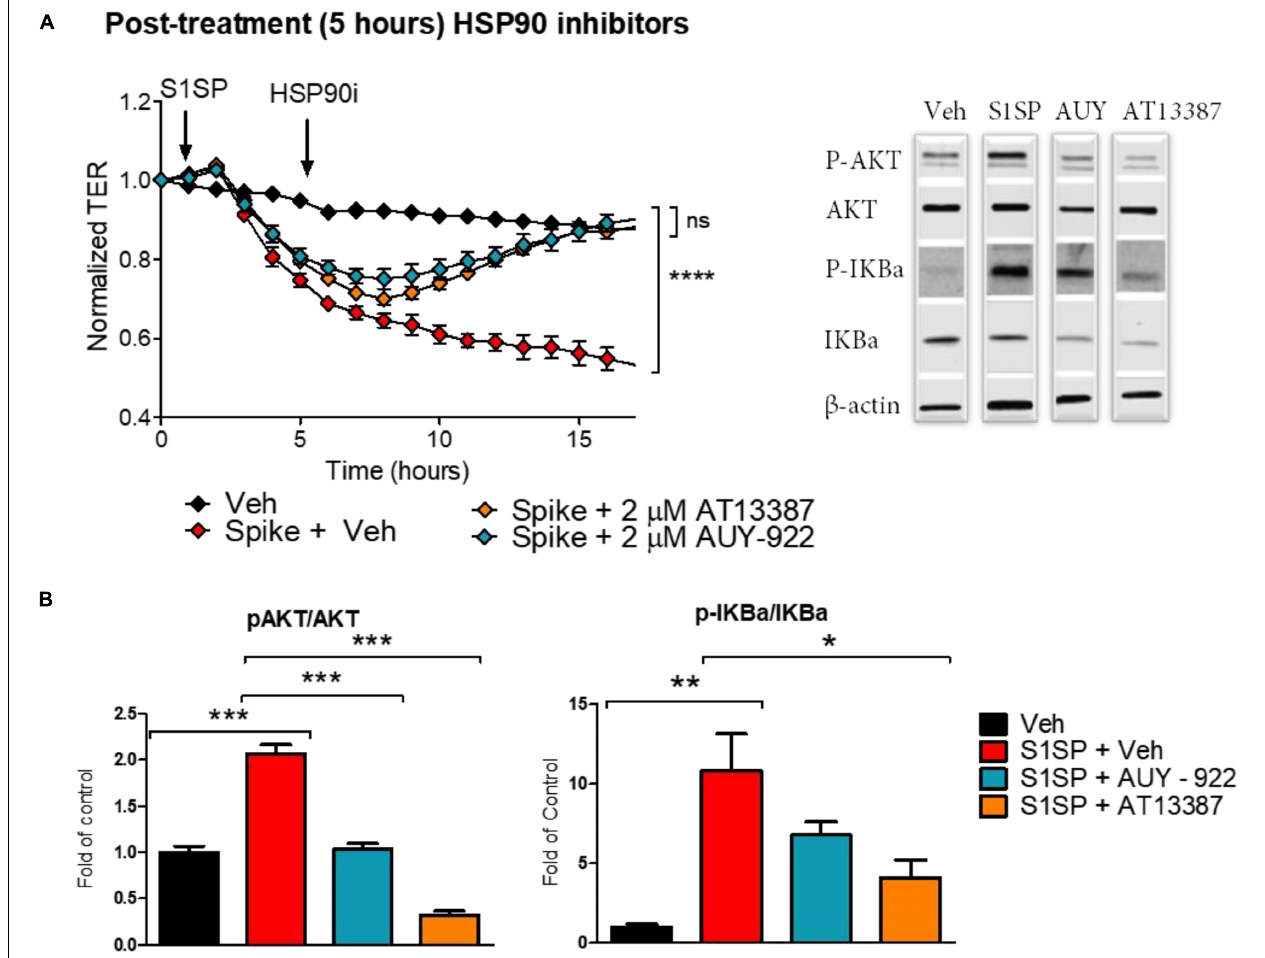
FIGURE 4 | Posttreatment with HSP90 inhibitors restored S1SP-mediated endothelial activation and barrier dysfunction. (A) Post-treatment with either of the two HSP90 inhibitors (2 µ M AUY-922 or AT13387) following 5 h of exposure to 20 nM S1SP repaired changes in TER. (B) Western blot analysis of activated (phosphorylated) and total AKT and IKB α in HLMVEC incubated for 5 h with S1SP followed by 4 h treatment with HSP90 inhibitors. Means ± SEM; n = 3–4; * p < 0.05; ** p < 0.01; *** p < 0.001 between groups, 1-way or 2-way ANOVA and Tukey’s or Bonferroni’s post hoc